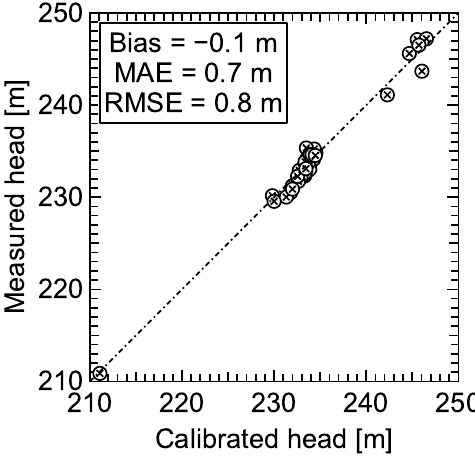
Figure 6. Cross-plot of measured and calibrated hydraulic